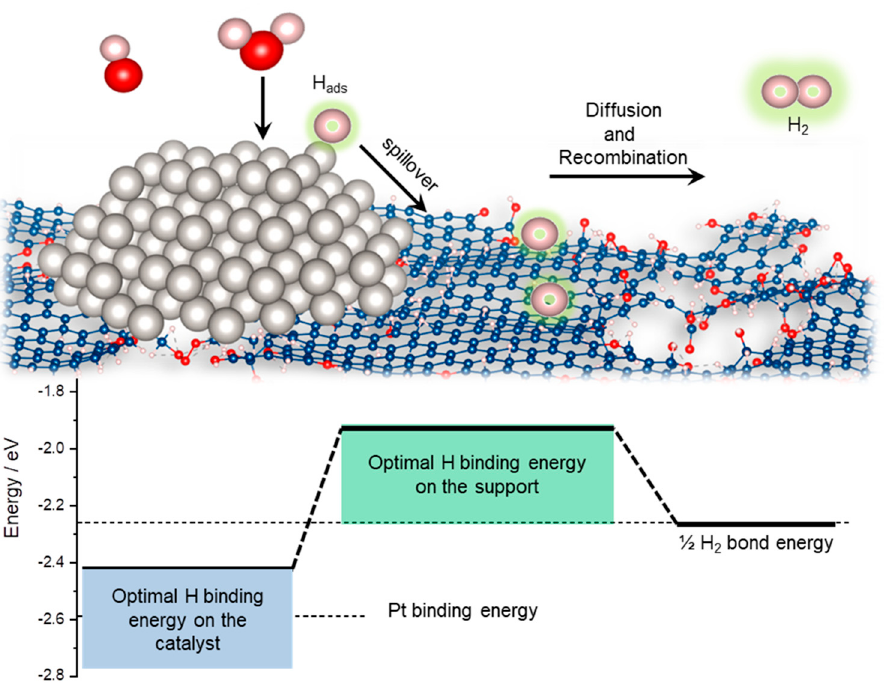
Figure 4. Schematic representation of the spillover process and H 2 production on the rGO-support metal catalyst with the energy profile for the considered reaction path.